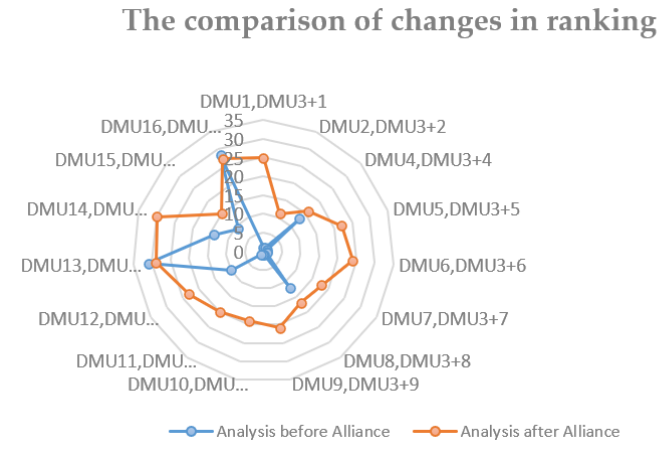
Figure 2. The comparison of changes in ranking.